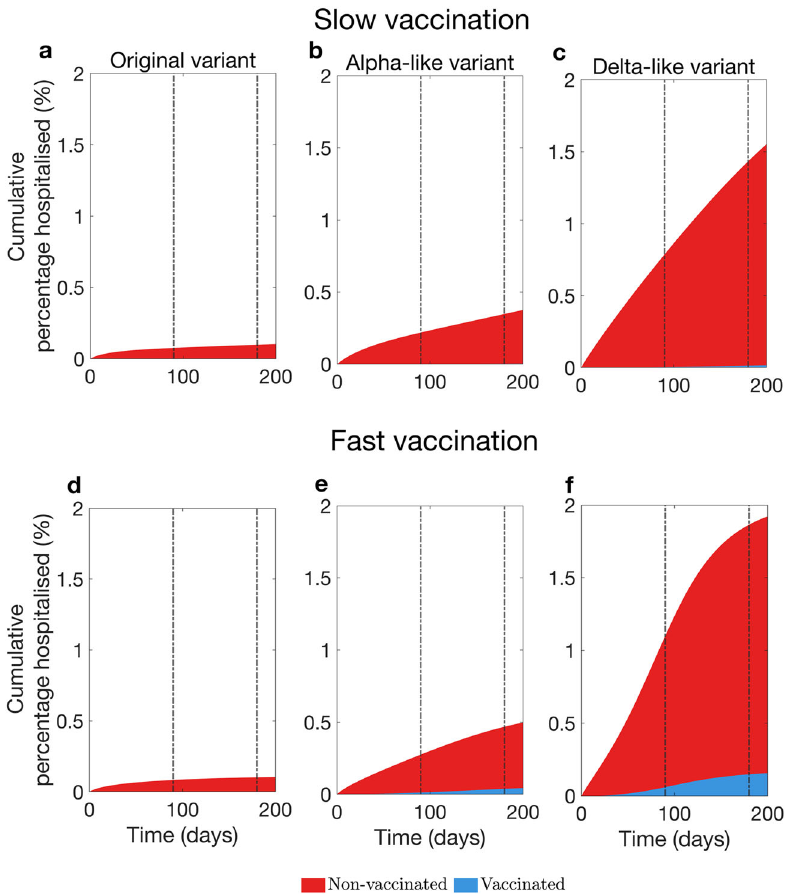
Fig. 5 Contribution of vaccinated and non-vaccinated individuals to percentage of hospitalised individuals during the vaccination rollout. We consider the scenario with low vaccine ef fi cacy in conferring immunity against acquisition of infection (60%). a – c show proportion of hospitalised population versus time given the slow vaccine uptake rate. d – f show the same output versus time given the fast vaccine uptake rate. a and d show this output for the original variant, b and e for an Alpha-like variant, c and f for a Delta-like variant. Vertical brown lines mark three and 6 months since the start of the vaccination campaign. We adjusted the percentage of hospitalised individuals so that it describes only new infections that appeared during the time interval that we